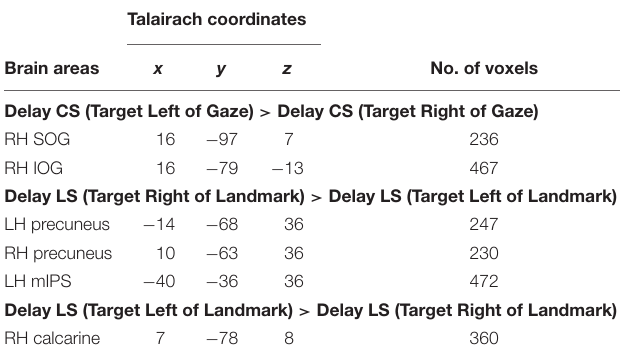
TABLE 4 | Talairach coordinates and number of voxels for contrast no. 3 and no. 4. Talairach coordinates Brain areas